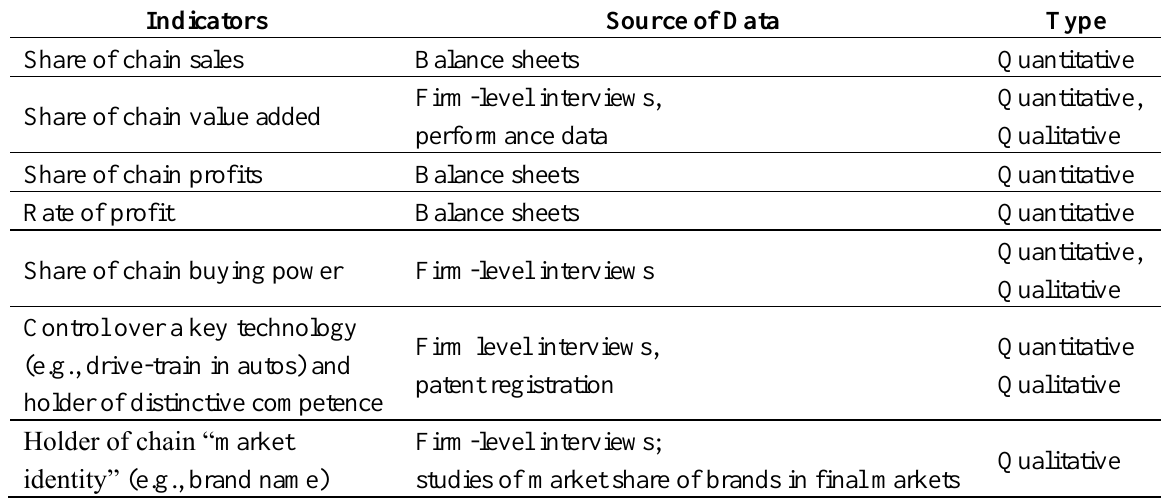
Table 4. Indicators of governance in the value chain